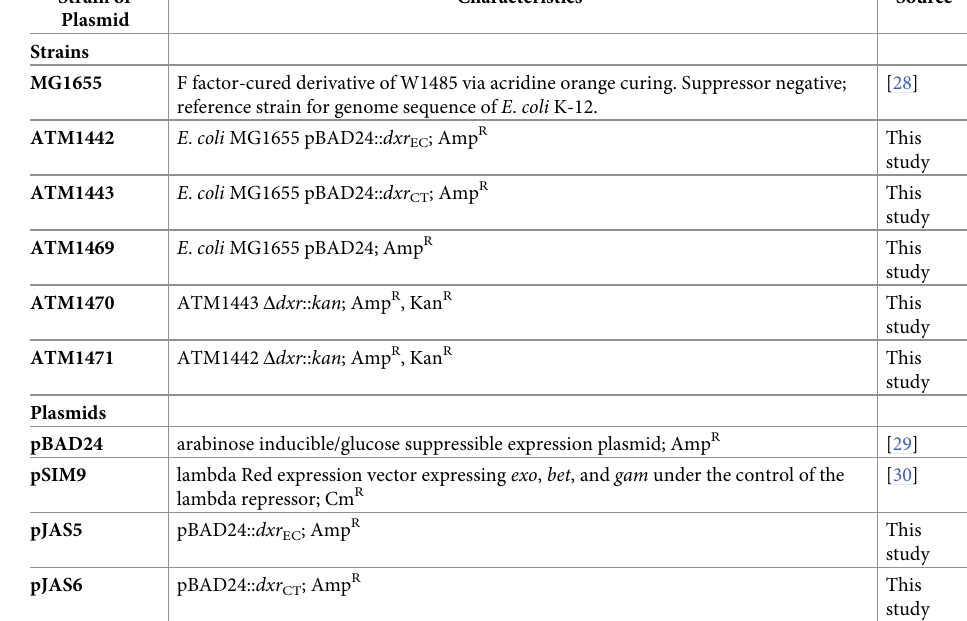
Table 1. Escherichia coli strains and plasmids used in this study. Strain or Characteristics a Source Plasmid MG1655 F factor-cured derivative of W1485 via acridine orange curing. Suppressor negative; reference strain for genome sequence of E . coli